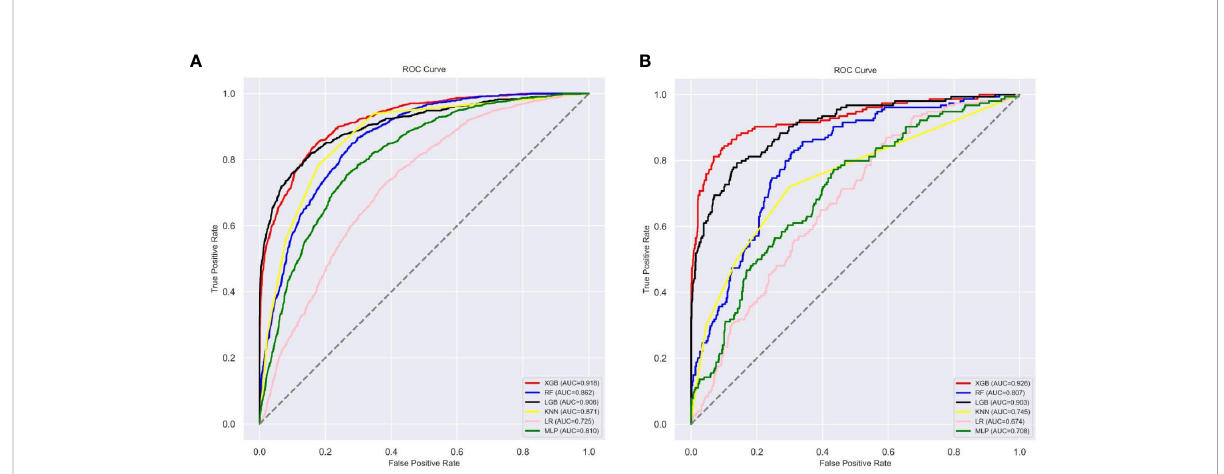
FIGURE 5 The roc curves of different machine learning models: (A) The roc curves of other machine learning models in the internal test set; (B) The roc curves of other machine learning models external test set. Abbreviations: LGBM, light gradient boosting; XGB, extreme gradient boosting; RF, random forest; LR, logistic regression; KNN, K-nearest neighbor; MLP multilayer perceptron; roc, receiver operating